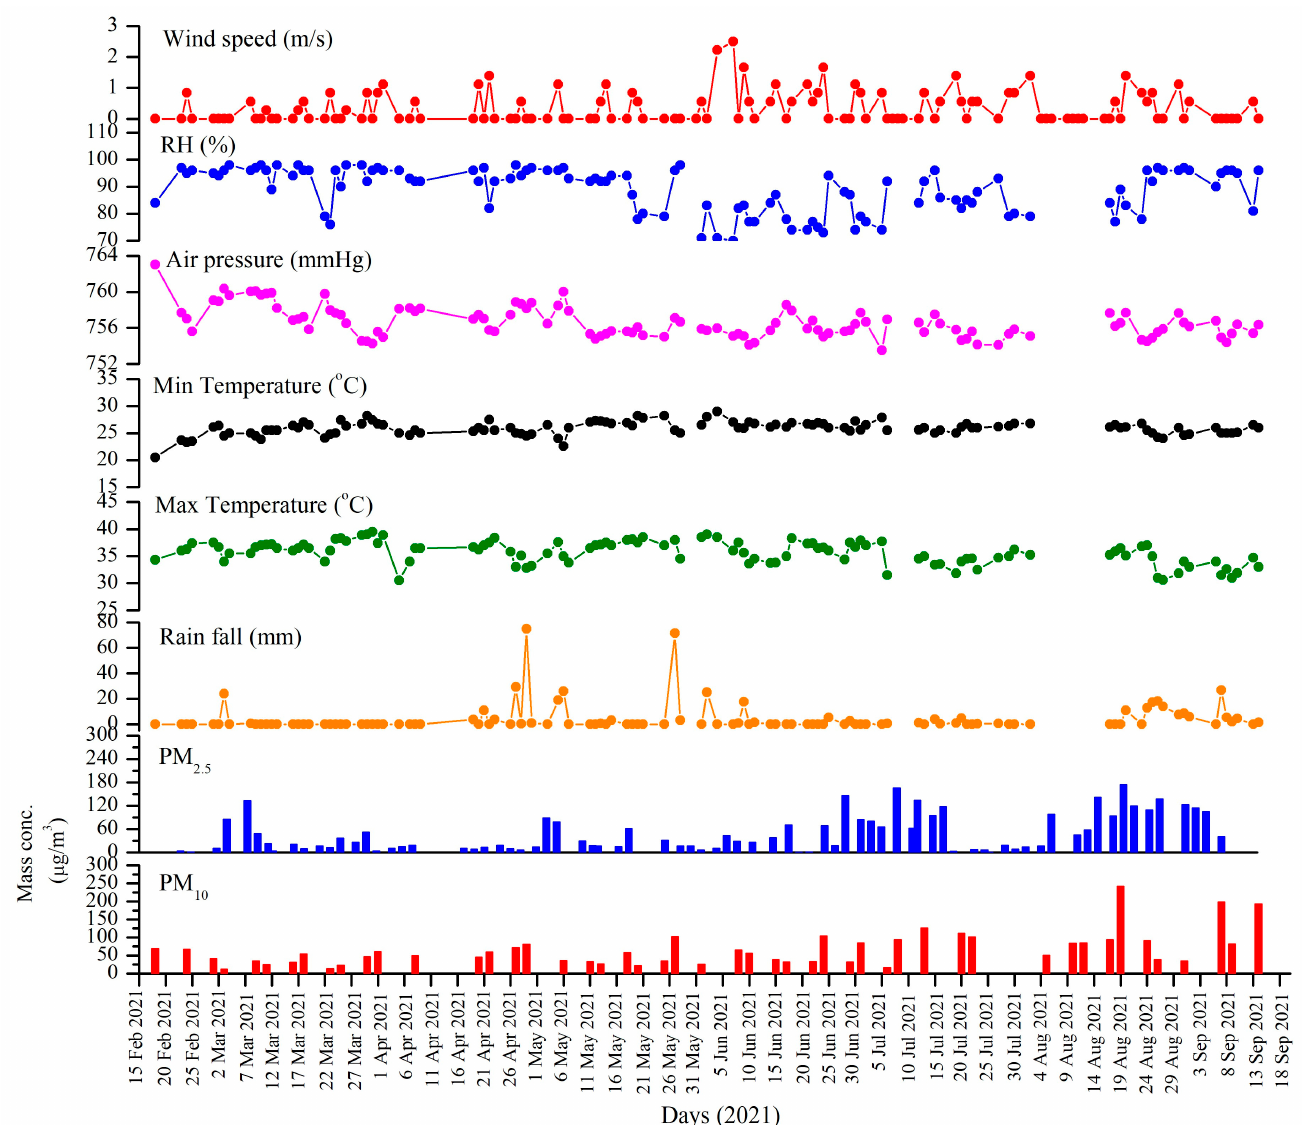
Figure 2. Temporal variations of PM 2.5 and PM 10 mass concentrations and meteorological parameters (rainfall, maximum temperature, minimum temperature, air pressure, relative humidity and wind speed) at the Pathum Thani sampling site in the suburban area of Thailand from 18 February to 14 September 2021.